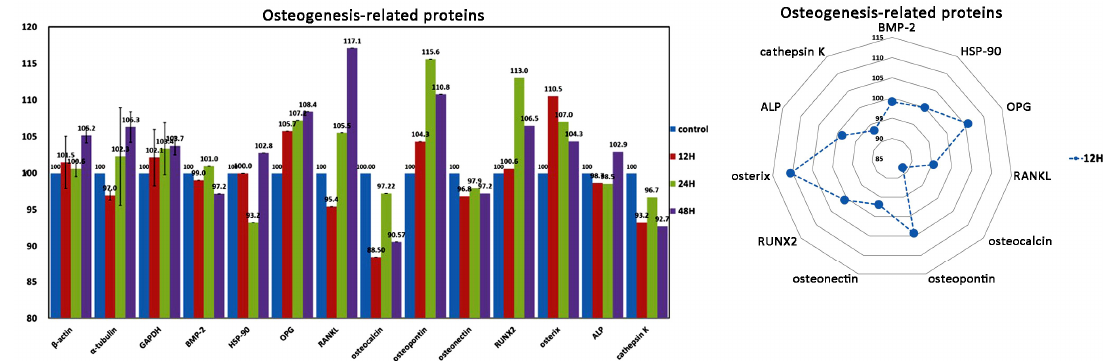
Figure 8. Changes to osteogenesis-related proteins after PTX treatment in RAW 264.7 cells. Left-sided graph shows changes to protein expressions according to the application time of PTX, blue bar; control group, red bar; 12 h treatment of PTX, green bar; 24 h treatment of PTX, purple bar; 48 h treatment of PTX. Right-sided polygonal graph shows protein expression profiles after 12 h treatment of PTX.